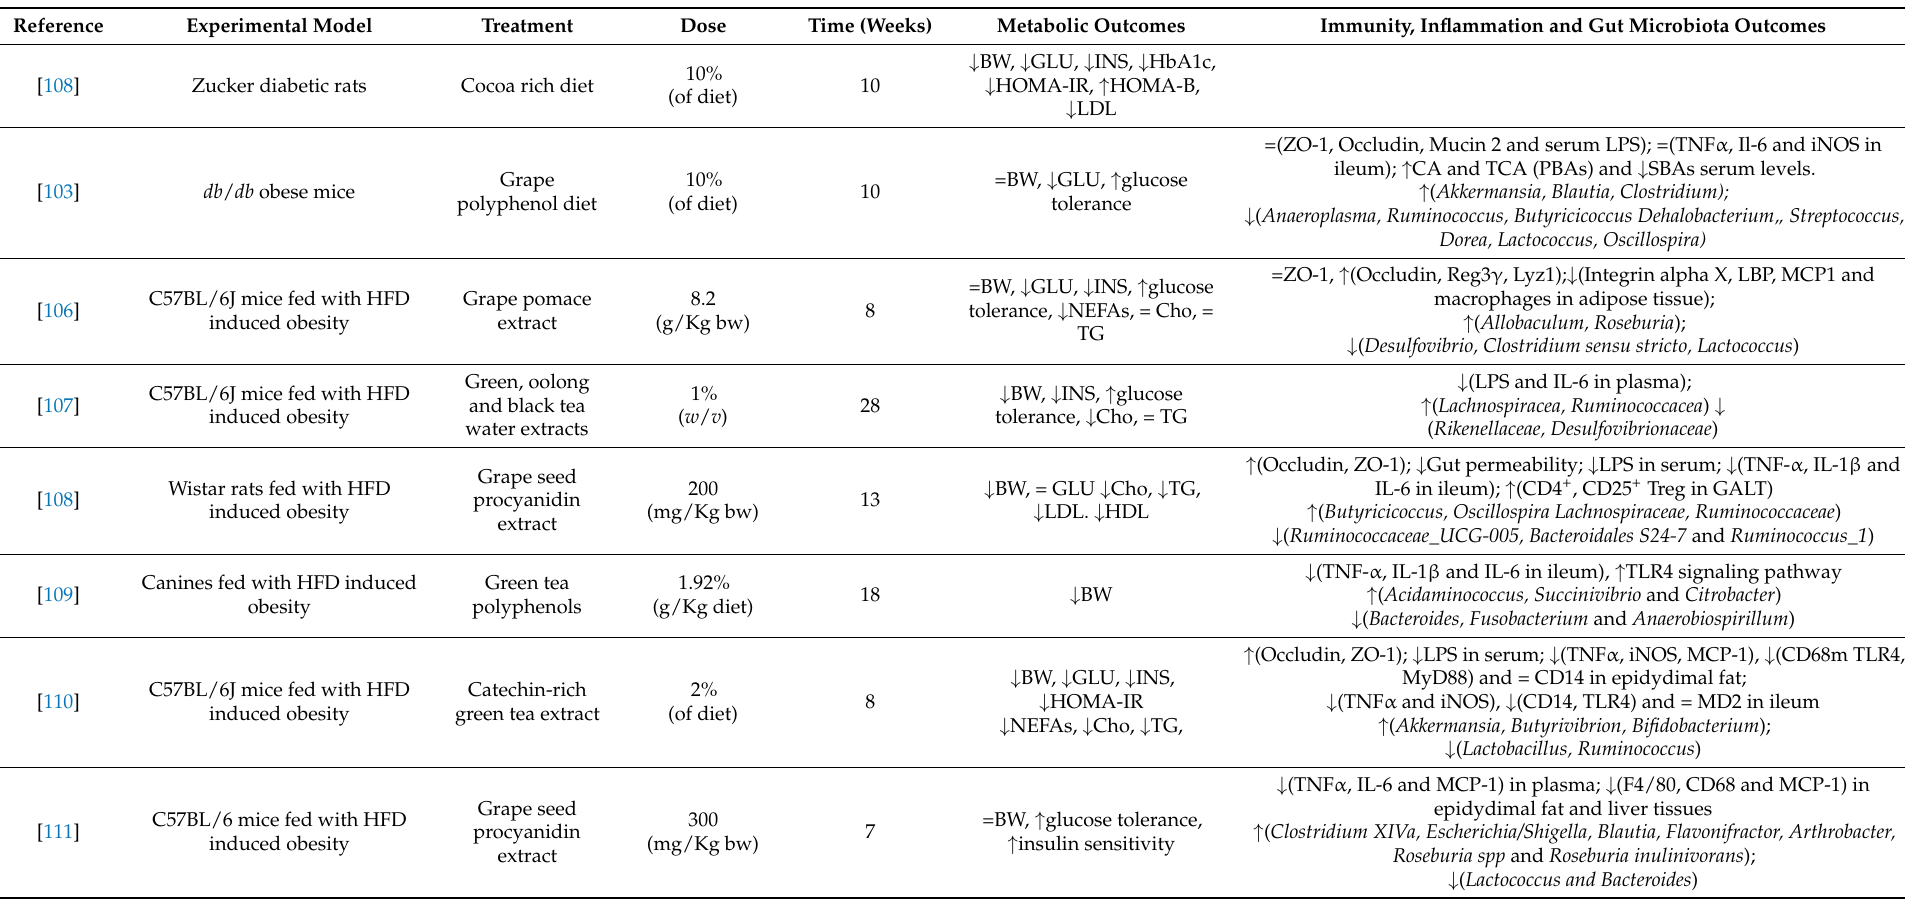
Table 3. Summary of the most relevant effects of flavanol and flavanol-rich products administration on metabolism, immunity, inflammation and gut microbiota during diabetes and obesity a